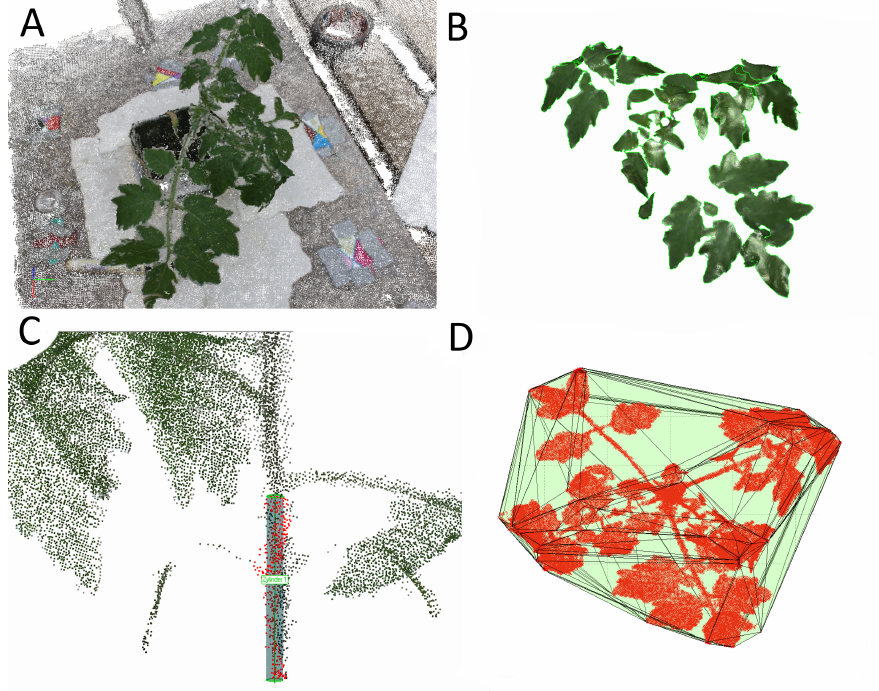
Figure 4. ( A ) The whole plant; ( B ) meshed leaves separated from stems and branches; ( C ) the measuring of the stem height; and ( D ) the computed 3D convex hull encompassing the plant.